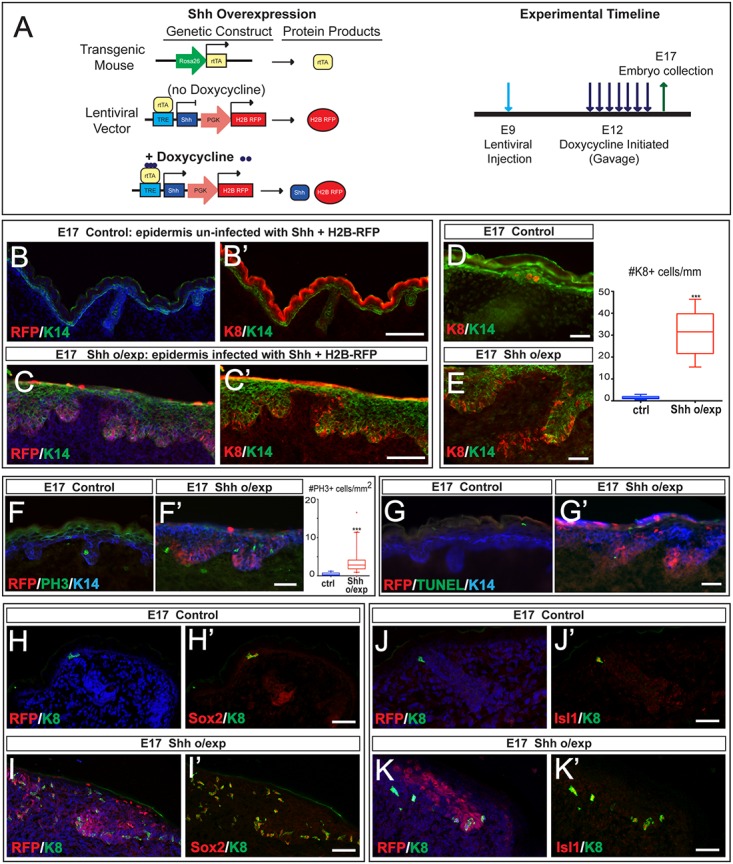
Shh overexpression results in increased formation of cells expressing Merkel markers.(A) Schematic diagram showing transgenic mouse and lentiviral constructs for the Shh overexpression experiment. CD1 female mice were mated with male Rosa26-rtTA mice and in utero lentiviral injections were performed in pregnant females E9. Doxycycline treatment was initiated by gavage at E12, and females were continuously fed Doxycycline until embryo collection at E17. In the presence of Doxycycline, lentivirus-injected mouse embryos express both H2B-RFP and Shh proteins. (B-E) IF stainings showing the altered morphology of epidermis infected with Shh+H2B-RFP (C,C’) and the significant increase in the numbers of Krt8(+) (K8) cells in the infected epidermis (C,C’,E) compared to control, un-infected epidermis (E17 control) (B,B’,D). Quantification of Krt8(+) cells per mm of back skin in E17 control and Shh overexpression (right panel) (p<0.0001). (F,F’) IF staining for Phospho-Histone H3 (PH3) showing a significant increase in proliferation in E17 Shh o/exp epidermis (F’) compared to control (F). Quantification of number of PH3(+) per mm2 of Krt14(+) epidermal cells is represented on the right (p<0.0001). (G,G’) TUNEL staining showing no increase in apoptosis in E17 Shh o/exp epidermis (G’) compared to control (G). Note that cells undergoing cornification are TUNEL(+), as previously reported [33]. (H-I’) IF staining showing an increase in the number of Sox2(+)/Krt8(+) cells in E17 Shh o/exp epidermis (I,I’) compared to control (H,H’). (J-K’) IF stainings showing an increase in the number of Isl1(+)/Krt8(+) cells in E17 Shh o/exp epidermis (K,K’) compared to control (J,J’). Scale bars: (B-C’): 100μm; (D-K’): 25 μm.